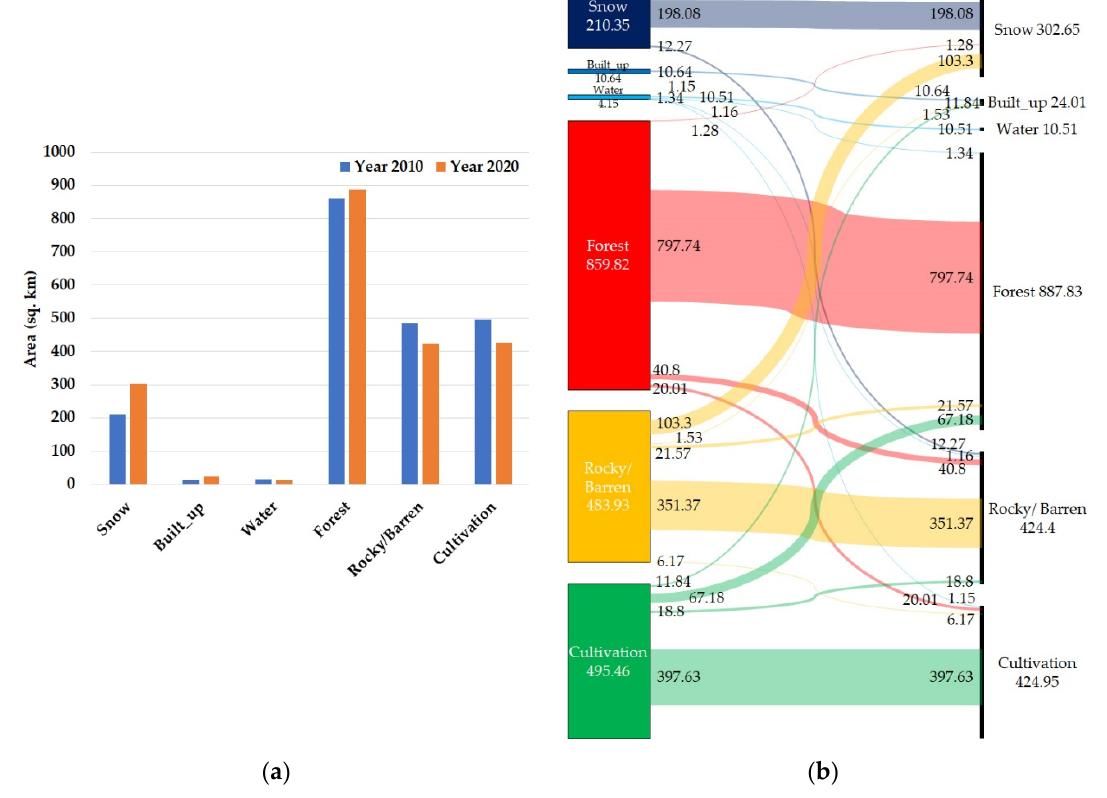
Figure 9. Changes in the LC area from the year 2010 to the year 2020: ( a ) Bar diagram; ( b ) Sankey diagram.